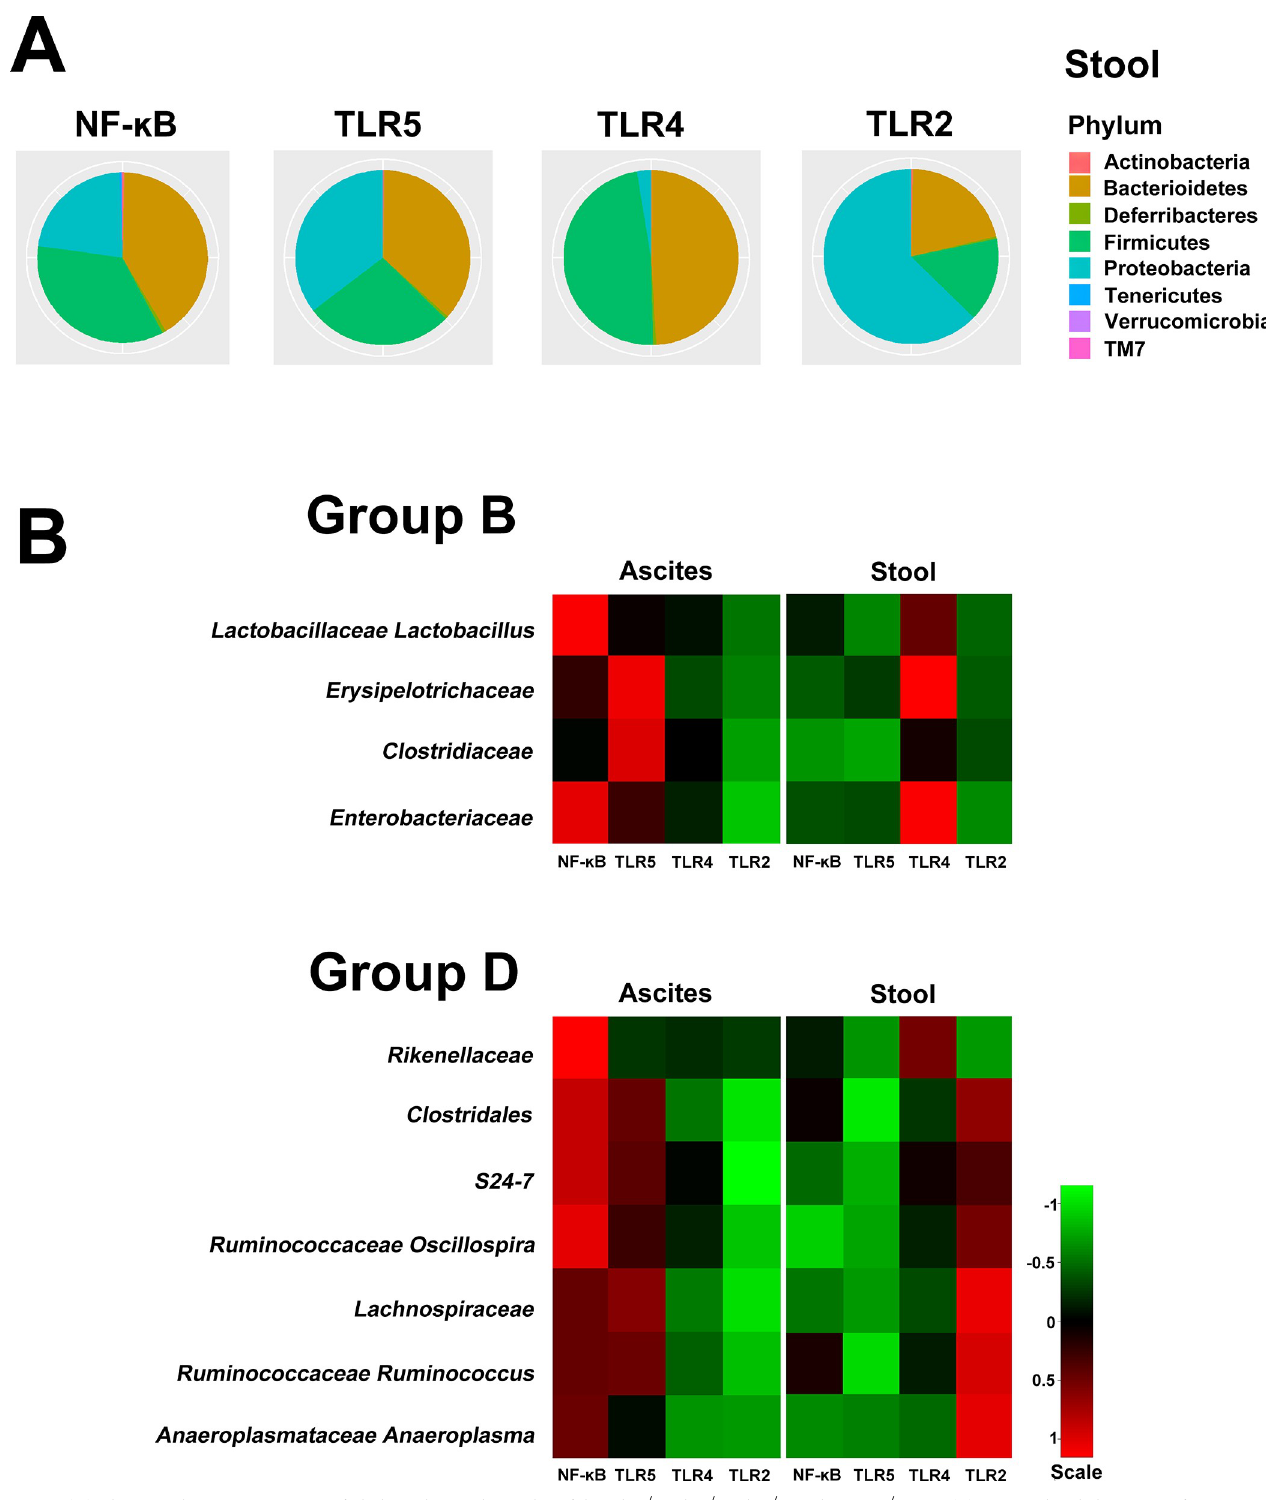
Fig 5. (A) The microbiota composition of phyla in the stool samples of the Tlr2 –/– , Tlr4 –/– , Tlr5 –/– , and NF- κ B –/– mice; (B), Hierarchical clustering of Groups B and C bacterial taxa from the ascites and stool samples from the metagenomic analysis in the Tlr2 –/– , Tlr4 –/– , Tlr5 –/– , and NF- κ B –/– mice. Quantity of 16S rRNA in the blood was not enough for the metagenomic analysis in the Tlr and NF- κ B knockout mice.